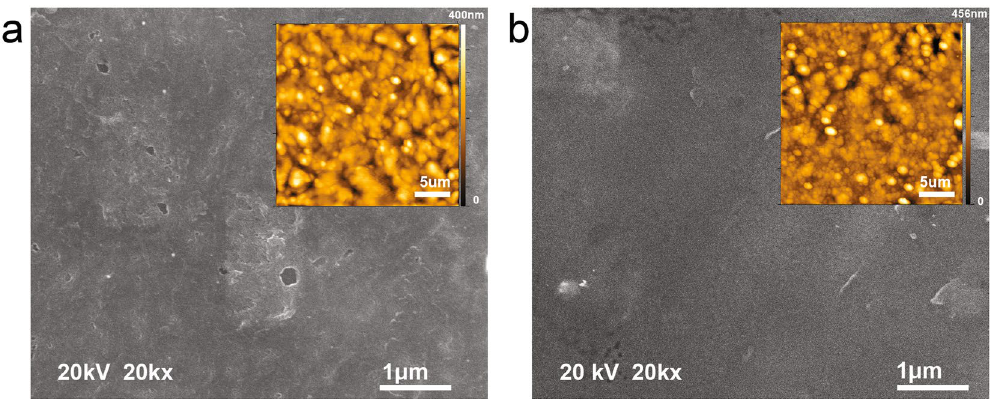
Figure 7. SEM and AFM image of microelectrode surface ( a ) before stimulation and ( b ) after 3.5 billion pulses of stimulation. The mean surface roughness was 43.55 ± 3.09 nm and 44.00 ± 6.69 nm (n = 4) before and after stimulation, respectively. t- test gave a nonsignificant difference ( P value > 0.05